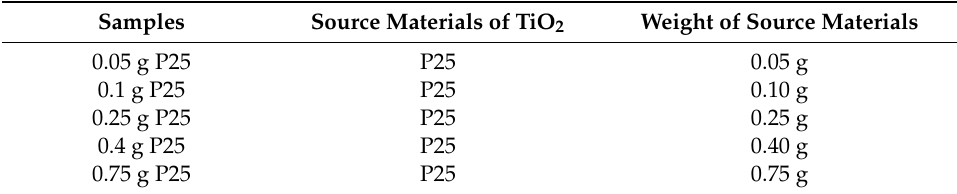
Table 2. The prepared samples of the P25